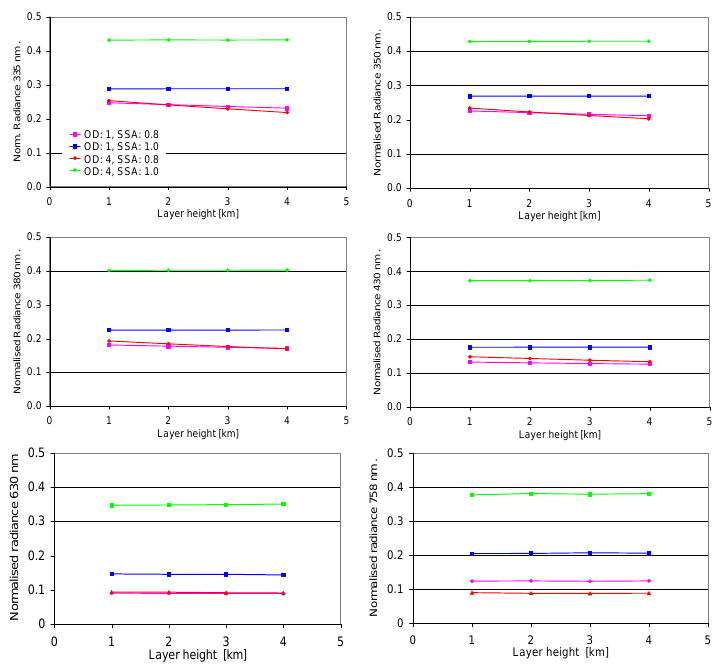
Fig. A6 Dependence of the normalised radiance on the aerosol layer height (the x-axis indicates the upper boundary of the aerosol layer; the lower boundary is the surface). The calculations are performed for SZA of 30° and viewing angle of -90° (nadir). The aerosol asymmetry parameter was assumed to be 0.68. For 758 nm the surface albedo was set to 20%, for 630 nm to 10%, and for all other wavelengths to 5%.